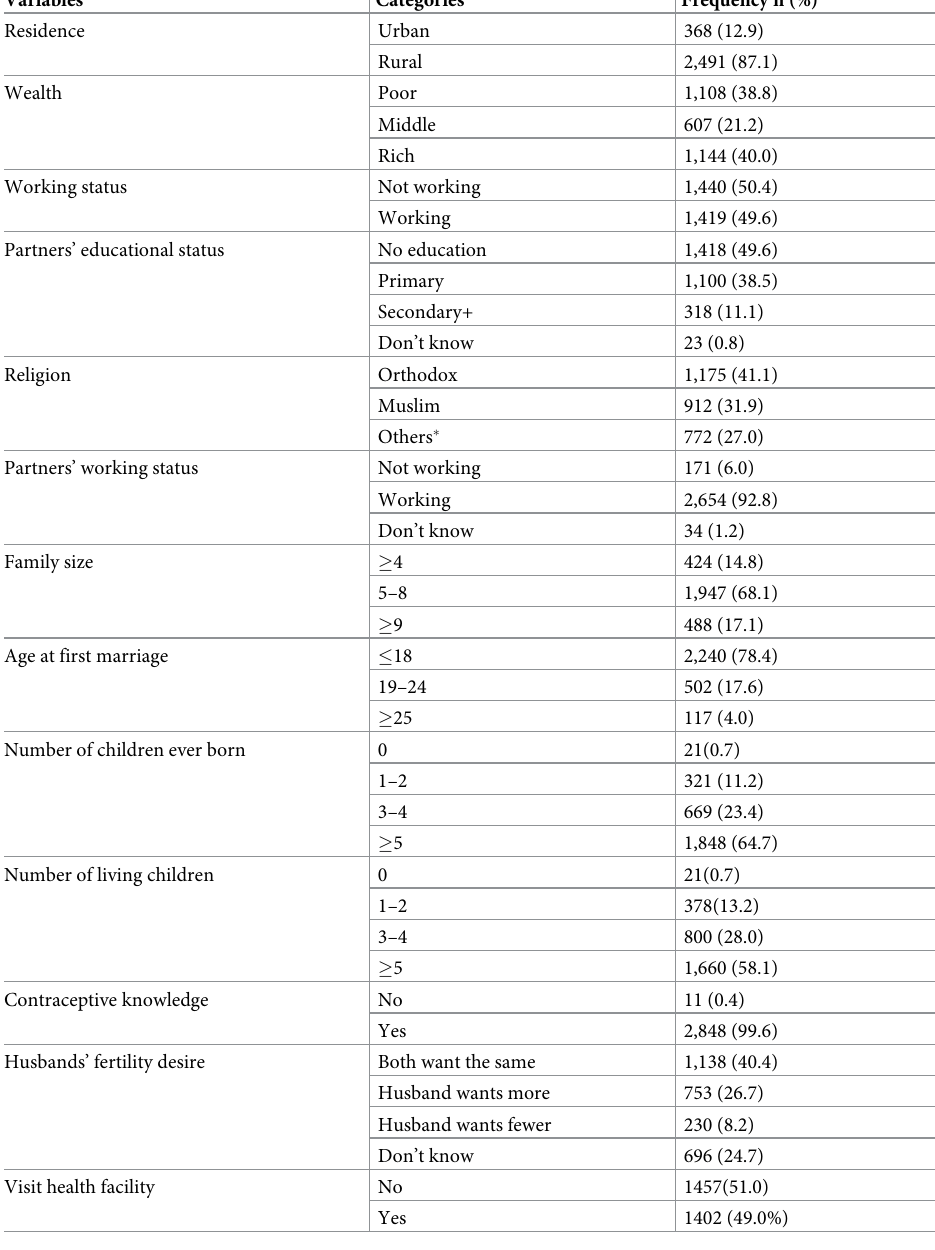
Table 1. Socio-demographic and other characteristics of fecund married women who want no more children in Ethiopia, 2016